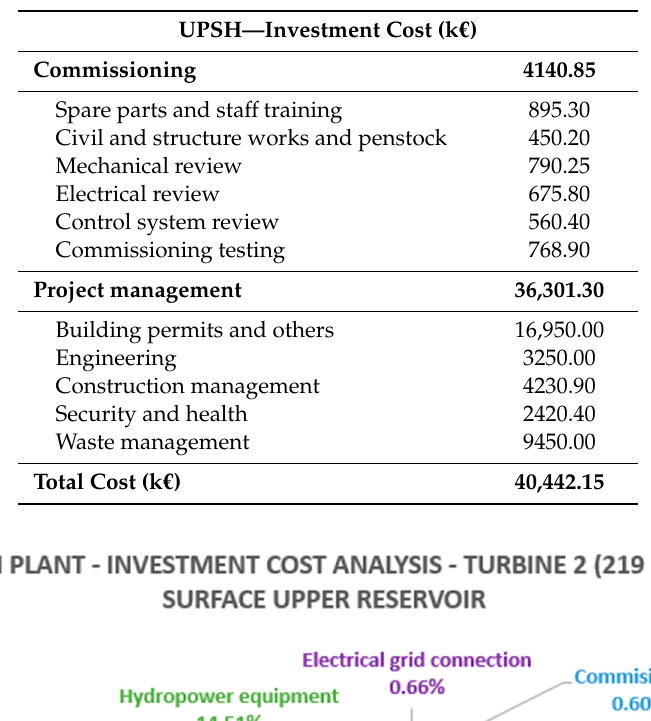
Table A2. Assessment of the investment costs of a UPSH plant, considering an FT with 219 MW of output power and a DTC of 8 h. Commissioning and project management.